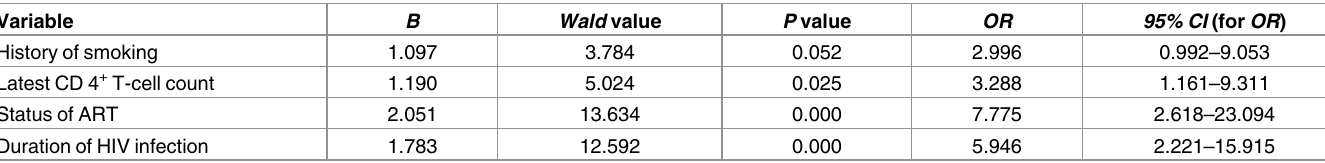
Table 4. Adjusted analysis for factors associatedwith